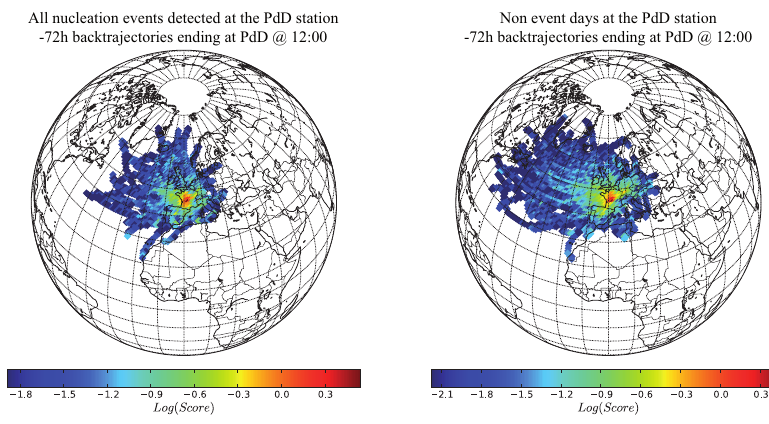
Fig. 4. Three days prior air mass backtrajectories computed with Hysplit